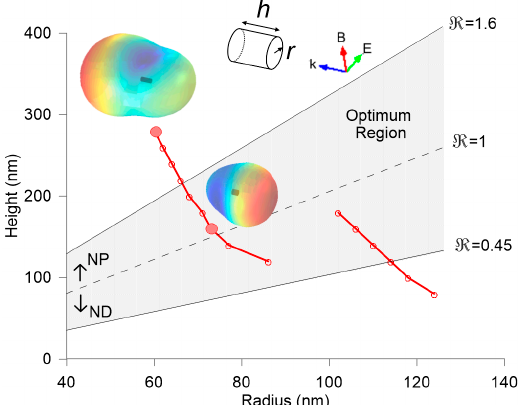
Figure 1. Aspect ratio (height vs. radius) of cylindrical silicon particles producing a minimum forward scattering at 632.8 nm in vacuum. The optimum observation region is delimited and shadowed. Two spatial distributions of the scattered electric field in the far-field region are included as insets, being as highest the intensity as reddish the color in a rainbow scale. Labels NP and ND refer to nanopillars and nanodisks, respectively and ℜ = h /2 r is the aspect ratio.